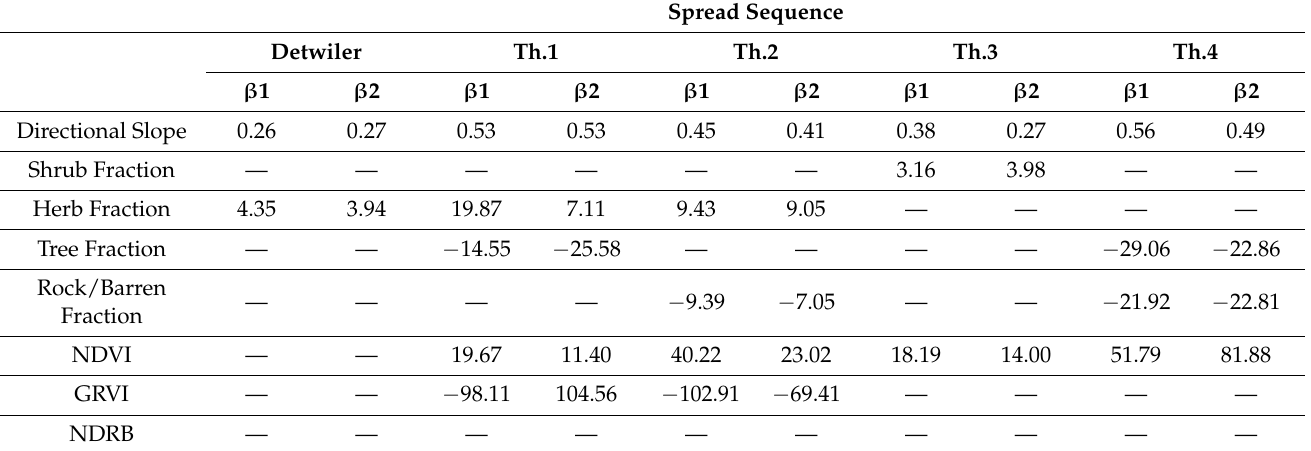
Comparisons of ESF and OLS (multiple stepwise regression) coefficients are docu- mented in Table 4. Directional slope relationships with ROS remain largely unchanged between multiple stepwise and ESF regression counterparts; however, vegetation fractional cover and spectral vegetation indices varied significantly between models. Table 4. Stepwise (b1) and ESF (b2) regression coefficient comparison of vector LSU models. Dashes (—) indicate an insignificant variable in the